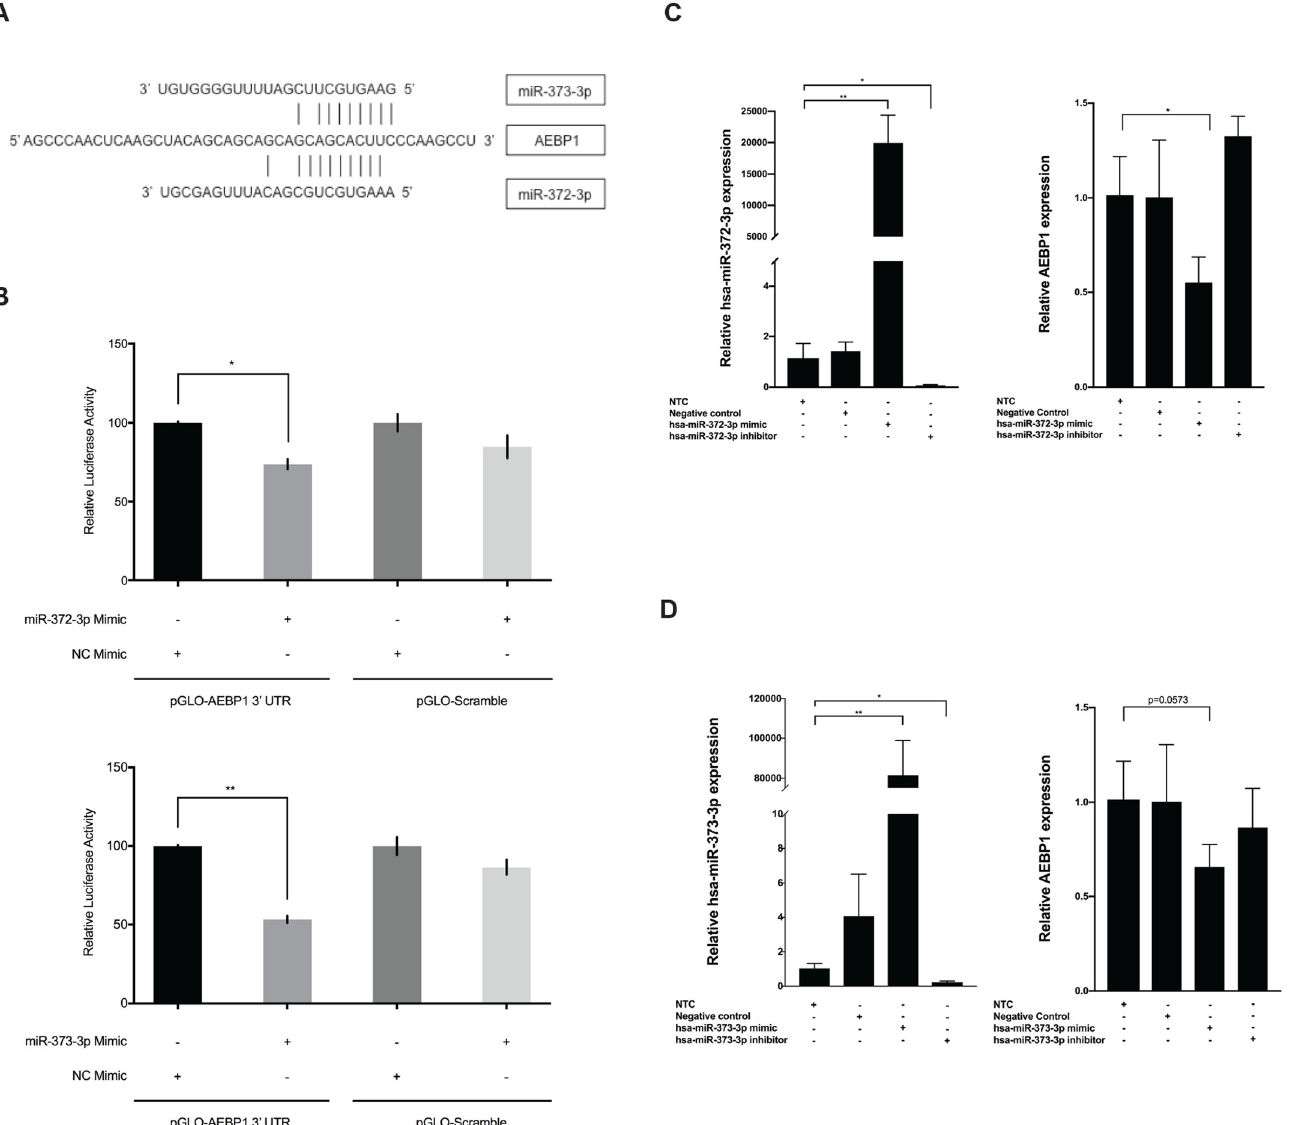
Fig 5. miR-372-3p and miR-373-3p functionally interact with AEBP1 to regulate its expression. A) The target site for miR-372-3p and miR-373-3p was predicted to align to positions 3829–3835 in the AEBP1 3’UTR (GenBank Accession NM_001129.4). Vertical lines indicate paired alignment between the miRNA seed region and AEBP1 3’UTR sequence. B) Approximately 20,000 human embryonic kidney 293 (HEK293) cells were co-transfected with the pGLO-AEBP1 3’UTR vector or scrambled control vector (pGLO-Scramble) and miR-372-3p mimic, miR-373-3p mimic, or scrambled sequence control miRNA (negative control [NC] mimic), and luciferase activity was measured 48 hours post-transfection using the Dual-Glo Luciferase Assay System (Promega). The ratio of firefly luciferase activity to renilla luciferase activity was determined for each sample and the firefly/renilla relative luminometer units (RLU) in HEK293 cells co-transfected with miRNA mimic and the pGLO-AEBP1 3’UTR vector were compared with those from cells co-transfected with pGLO-Scramble and NC mimic. The Mann-Whitney U test was used to assess differences between conditions; differences between the negative controls were not statistically significant. For functional studies, activated LX-2 cells were transfected with 75 nM mirVana miRNA-372-3p/miR-373-3p mimic, 75 nM anti-miR-372-3p/miR-373-3p inhibitor, or 75 nM scrambled sequence control. After 48 hours cells were harvested and total RNA was extracted. The TaqMan RNA-to-Ct 1-Step kit (Thermo Fisher Scientific) and TaqMan commercial primers were used to measure C) miR-372-3p and AEBP1 levels and D) miR-373-3p and AEBP1 levels in the presence of the respective mimic and siRNA. Cycle threshold levels were generated using QuantStudio Real-Time PCR Software 1.0. miRNA and mRNA data were normalized using RNU6B + RNU48 and GAPDH , respectively. Black bars represent the scrambled miRNA negative control, while the gray bars represent treatment conditions. All experiments were performed in triplicate. Data are means ± SD. A paired t-test was used to compare the treatment group to the no treatment control group (NTC) � P < 0.05; �� P < 0.001; ��� P <